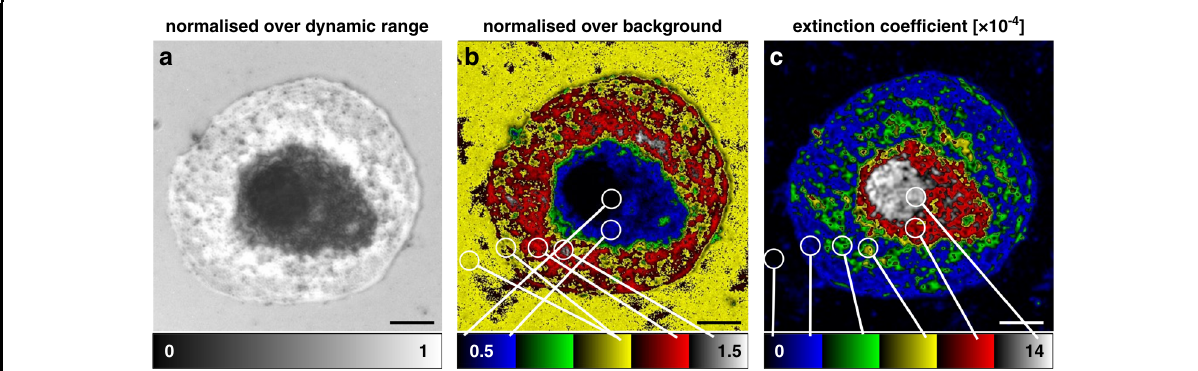
Fig. 4 Extinction coef fi cient measurements of LSECs. a LSEC raw intensity image normalized over the dynamic range of the camera. b Normalization to the background of the fl at- fi eld corrected intensity image. Due to interference of illuminated and scattered light, the sieve plates appear with pixel values above both background and nucleus (yellow/blue vs red/white in the used 5-ramp colormap). c Extinction coef fi cient map of the same LSEC. After qDPC processing, the complex phase gives access to quantitative extinction coef fi cients. The sample now shows values linearly increasing from the non-absorbing background to the strongly absorbing nucleus. The white encircled areas in ( b ) and ( c ) show patches of various cellular compartments (background, rim, plasma membrane/sieve plates, cell body, nucleus) that exemplify the qualitativeness or quantitativeness of the two modalities, respectively. Scale bars are 5 µm